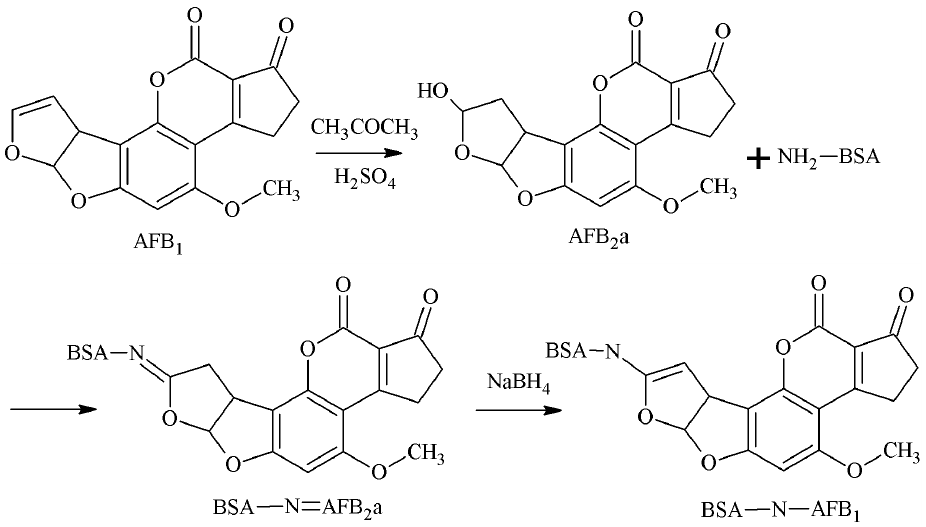
Figure 5. Synthesis of the AFB1-BSA antigen by the semi-acetal (SA) method.